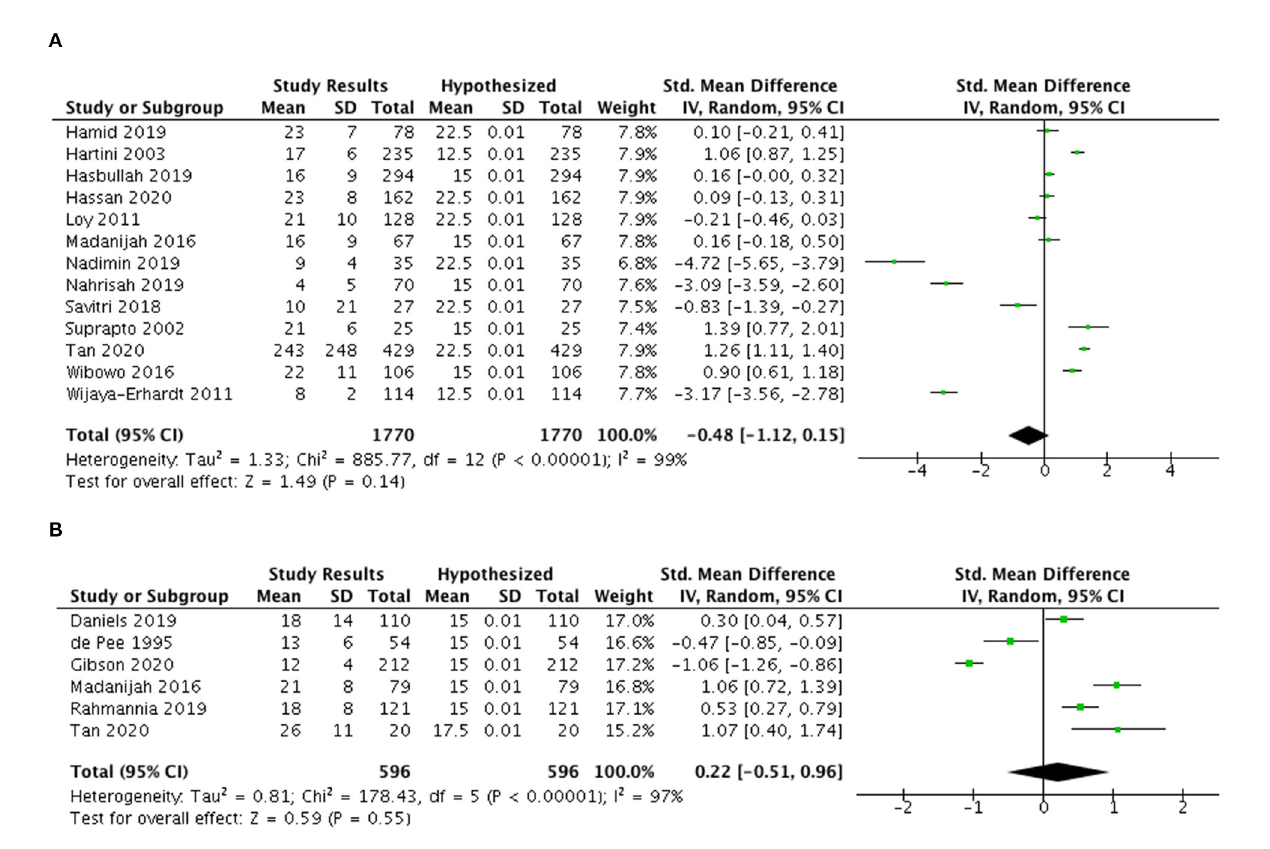
FIGURE4 Meta-analysis of studies on iron intake (A) among pregnant women and (B) lactating women in Indonesia and Malaysia.